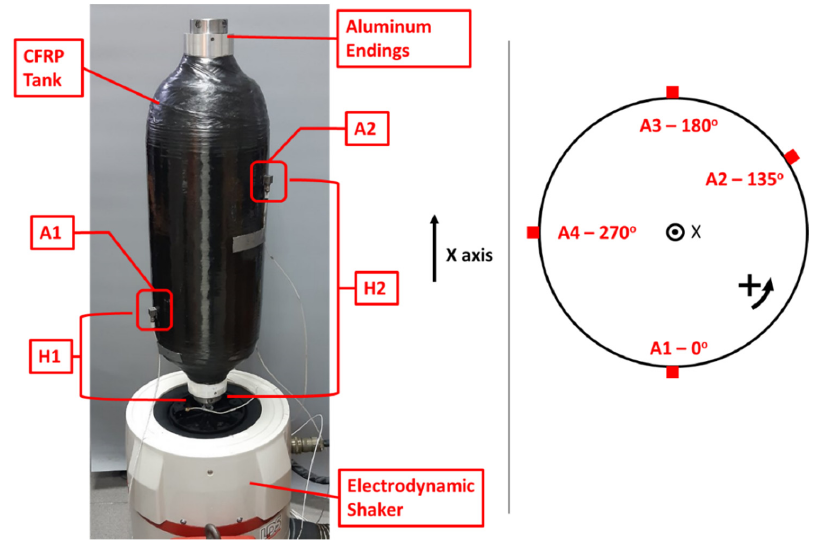
Table 1. Accelerometer location.